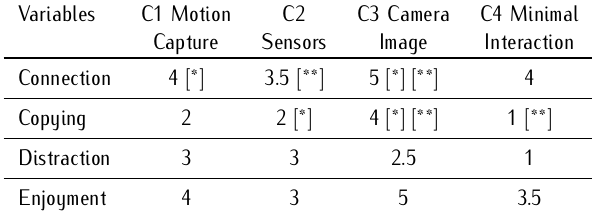
Table 5. Overall trend of the 4 variables with the 4 conditions ([*] or [**] – statistical validity in pairwise